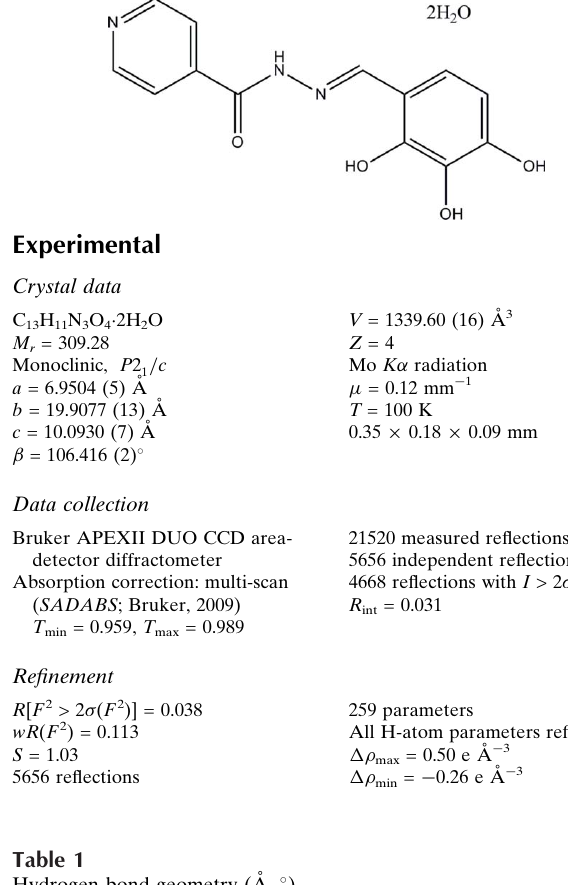
Hydrogen-bond geometry (A˚ , (cid:3) ). D —H (cid:2)(cid:2)(cid:2)